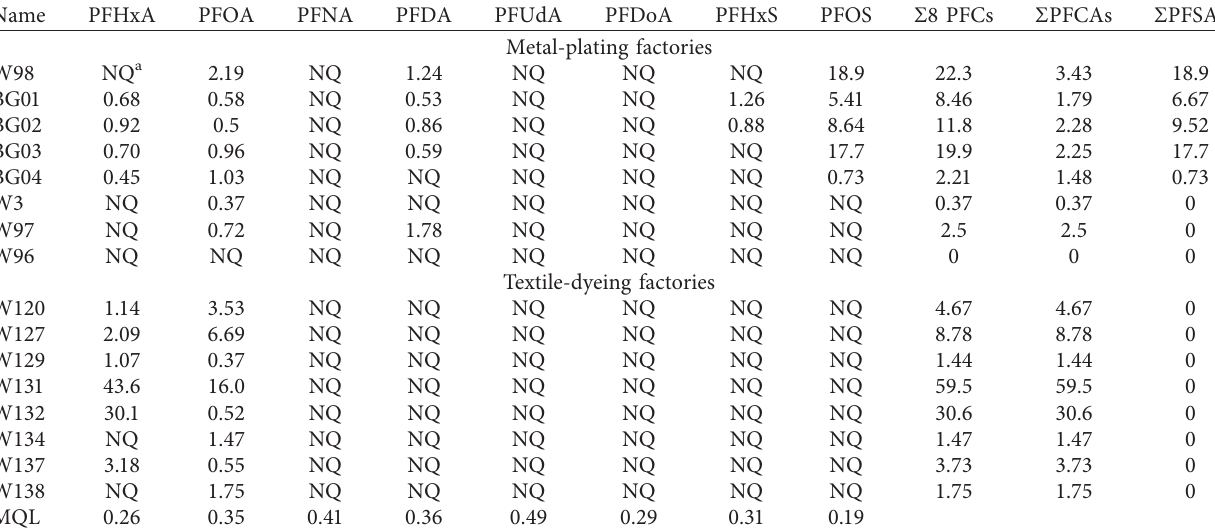
Table 2: Concentrations of PFASs (ng/L) in wastewater of selected metal-plating factories and textile-dyeing factories in